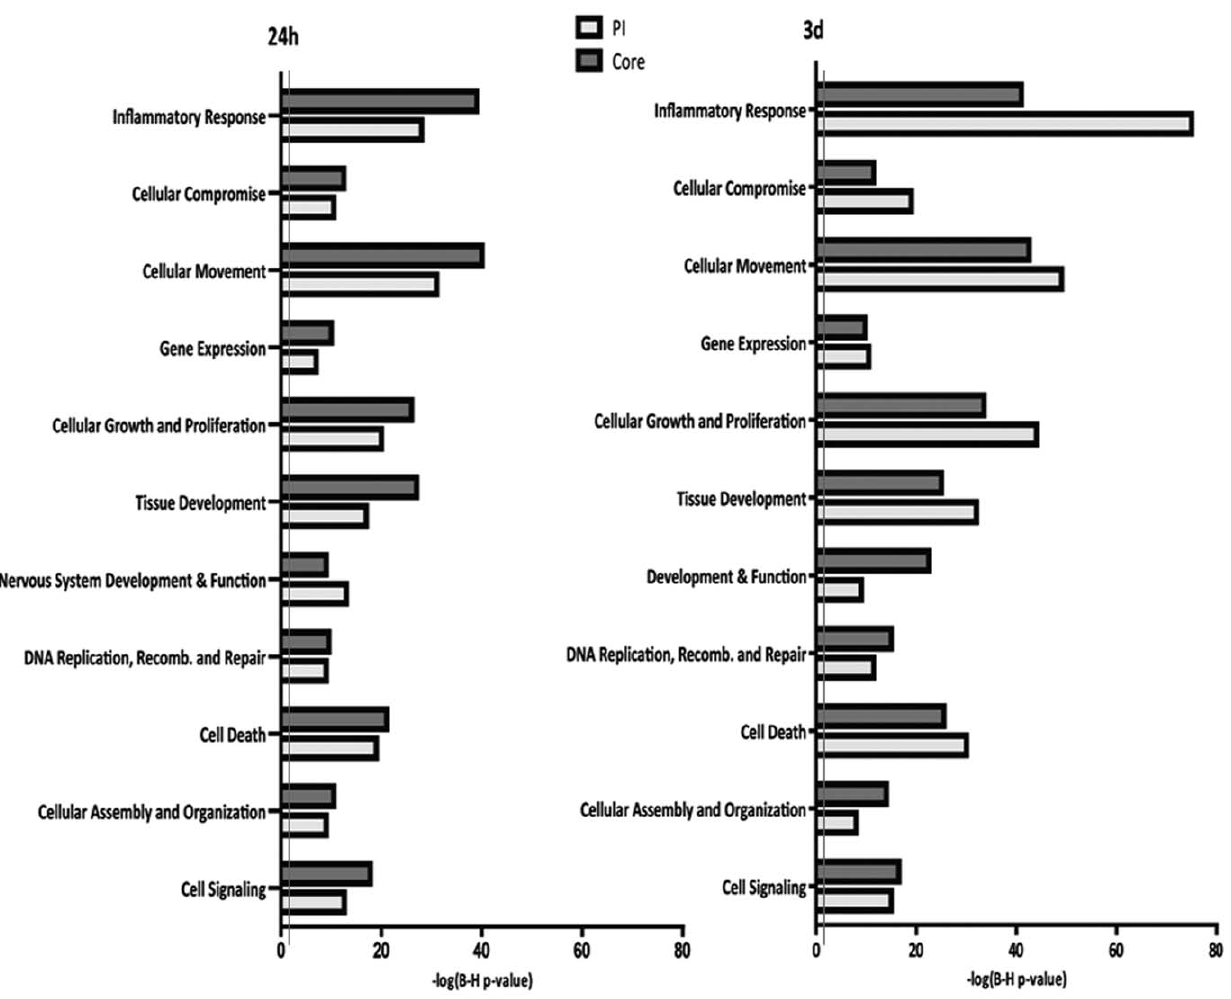
Figure 4. Biological functions that were significantly regulated in both core and periinfarct following focal cerebral ischemia. Biological functions calculated using Ingenuity pathway analysis (IPA) showed that all functions were significantly regulated in both core and periinfarct (PI) following pMCAO in both the 24 hour and 3 day groups ( P , 0.05; B – H Multiple testing p-value correction was selected).